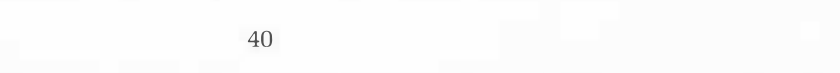
Figure 1 The location of ancient Tebtu­ nis and Memphis in relation to the Fayum depression and the northern valley and delta of the Nile.